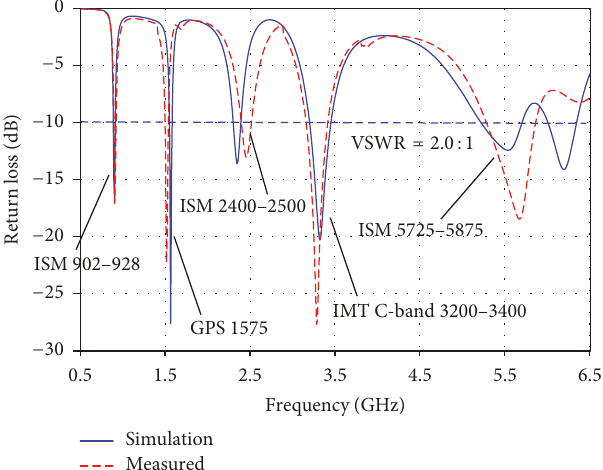
Figure 2: Measured and simulated return loss for the proposed